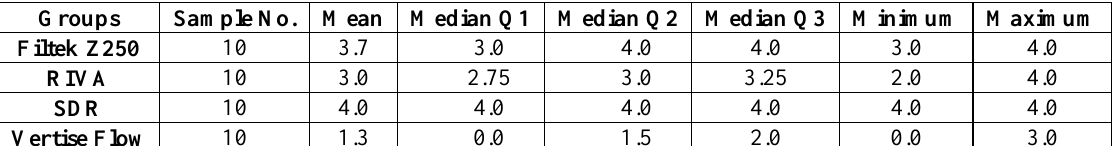
Table 3: Descriptive statistics of microleakage for groups